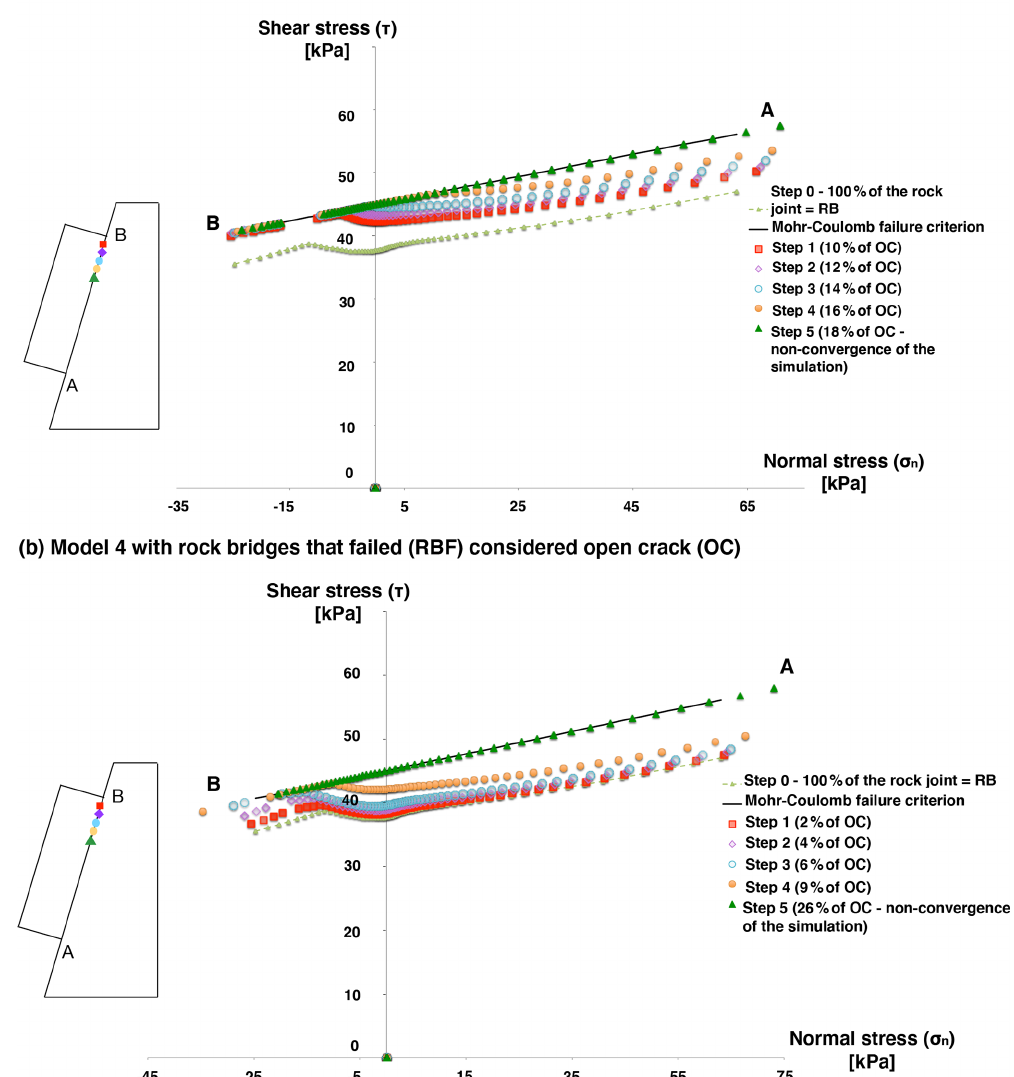
Figure 11. Normal and shear stress distribution for (a) model 1 in the case where three types of contact are considered (open crack (OC), rock bridge (RB), rock bridge that failed (RBF)) and (b) model 4 if the contacts defined as rock bridges that failed are automatically changed to open crack (OC) – Scenario